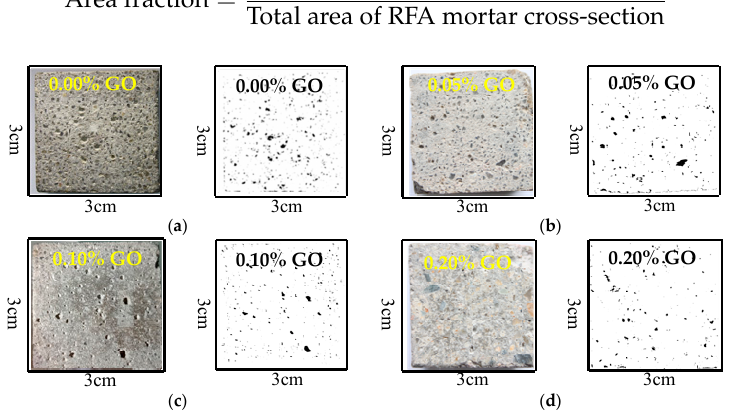
Figure 16. Binary images of the two-dimensional (2-D) distribution of air voids in the RFA mortars at 28 days. ( a ) Area fraction: 2.3%; ( b ) Area fraction: 1.9%; ( c ) Area fraction: 1.7%; and, ( d ) Area fraction: